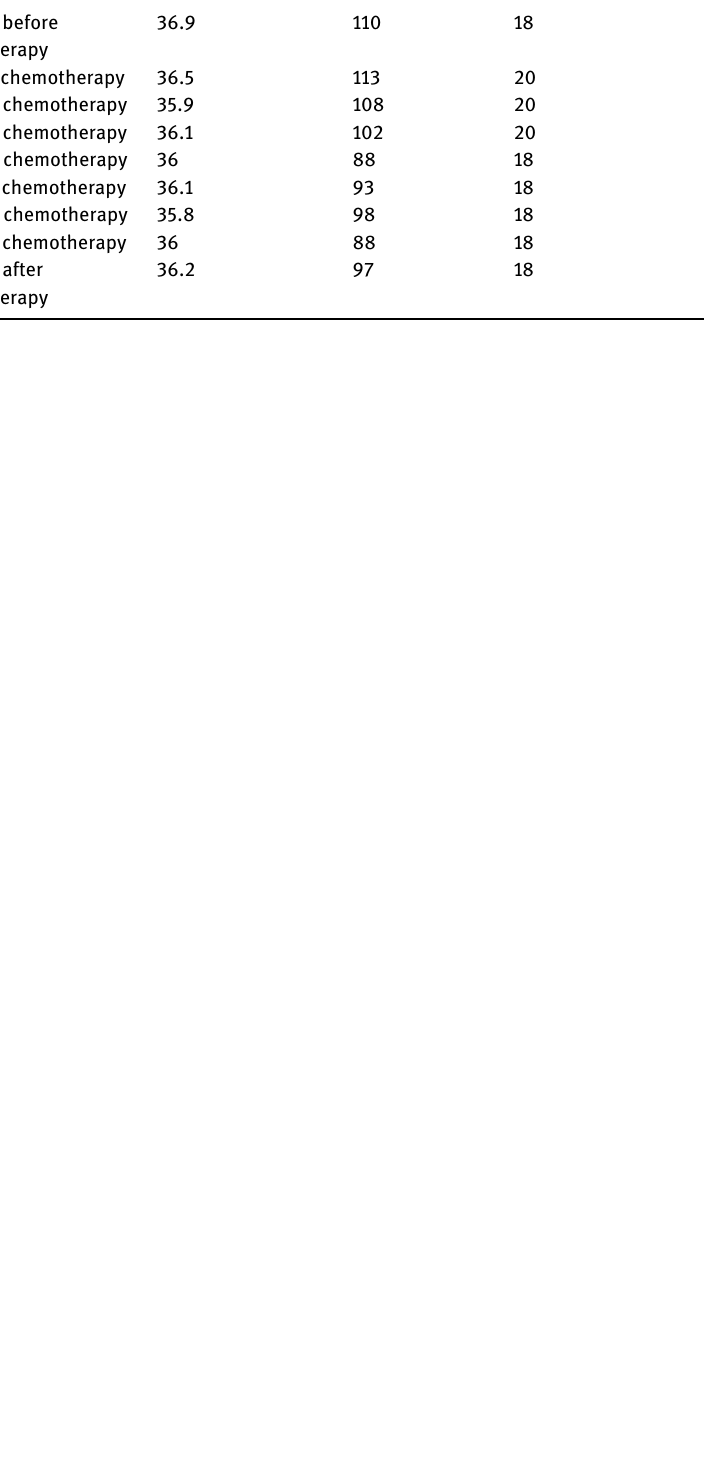
Body Heart rate ( per minute temperature ( °C )